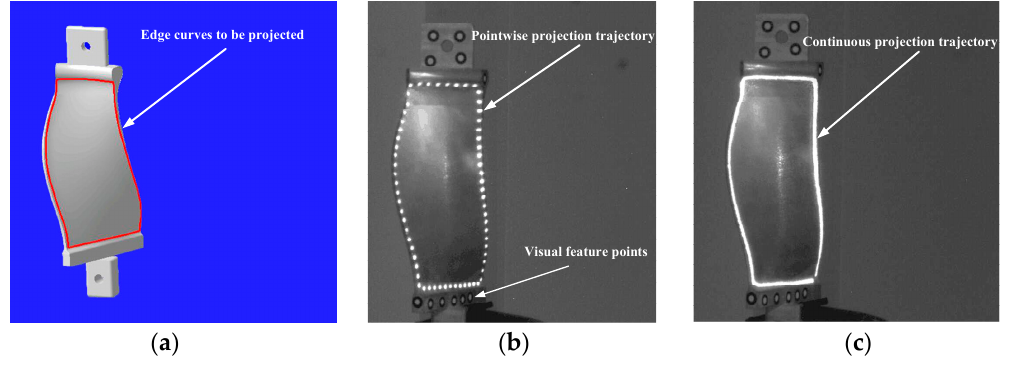
Figure 13. The projection positioning experiment. ( a ) The CAD model of the engine blade. ( b ) Projection result in point scan mode. ( c ) Projection result in linear interpolation scan mode.